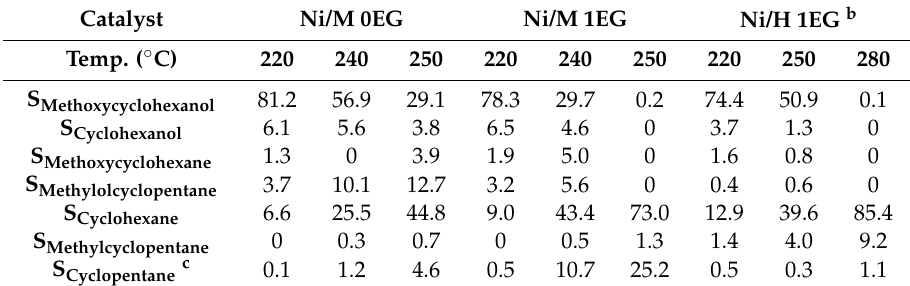
Table 4. Hydrodeoxygenation activity of guaiacol on various catalysts under high temperature a .